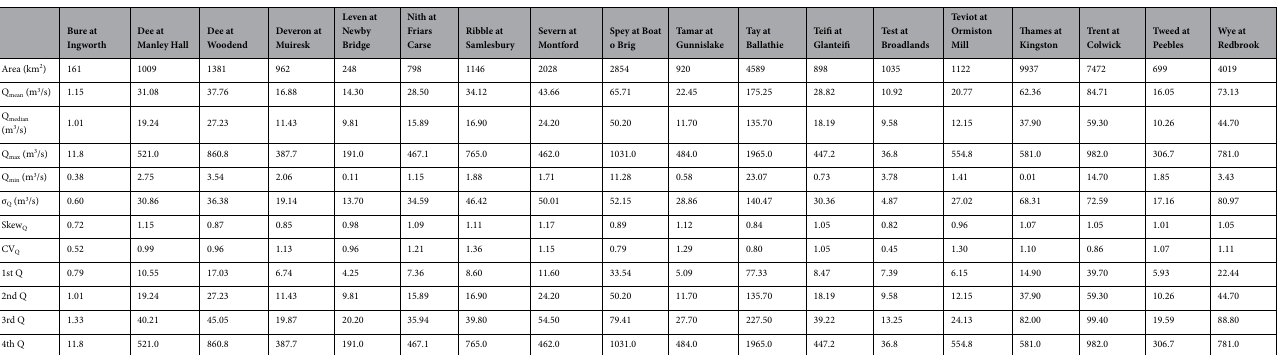
Table 1. Catchment area and streamflow rate statistics for each basin. where: Area = catchment area,